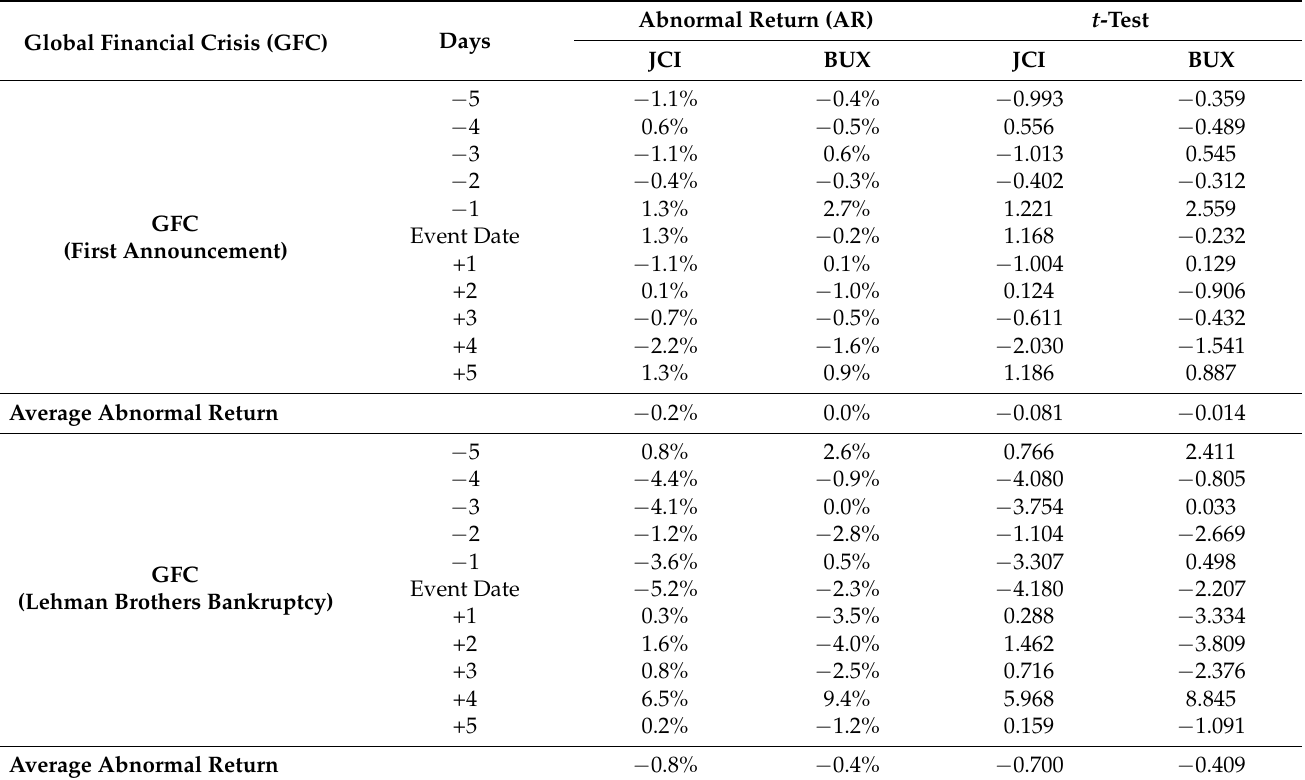
Figure 2 chart line of cumulative abnormal return of JCI during COVID ‐ 19 (epidemic